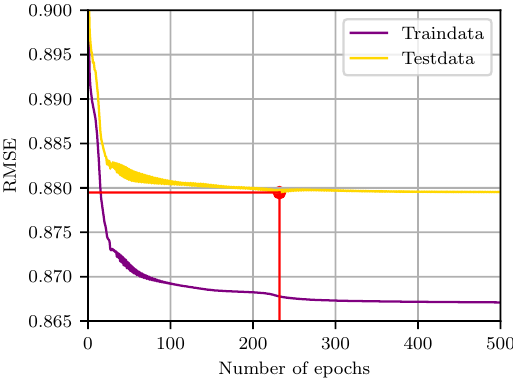
Figure 5. The optimal number of training epochs is 232, resulting in an RMSE of the testing data of 0.879.